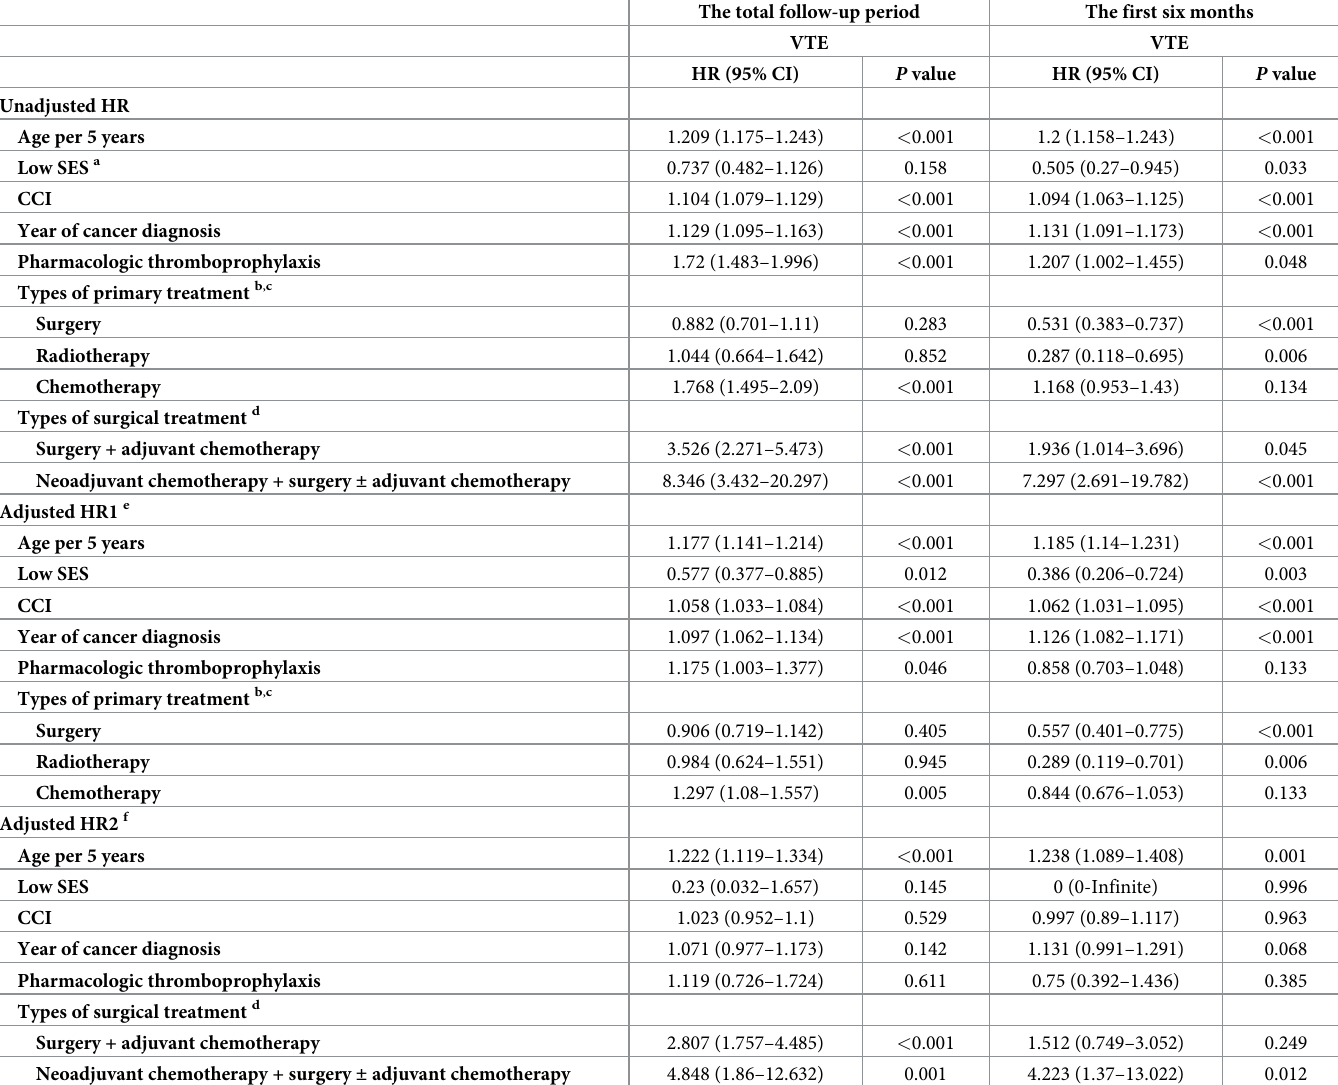
Table 3. Association of risk factors with VTE occurrence in women with ovarian cancer (HIRA claims data of